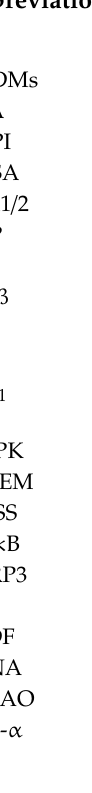
Figure S1: Administration of a lysophosphatidic acid receptor 1 (LPA 1 ) antagonist, AM095, reduced neurological deficit score in mice after transient middle cerebral artery occlusion (tMCAO) challenge. Figure S2: AM152, an LPA 1 antagonist, does not inhibit NF- κ B phosphorylation in lipopolysaccharide (LPS)-primed BMDMs, followed by lysophosphatidic acid (LPA)